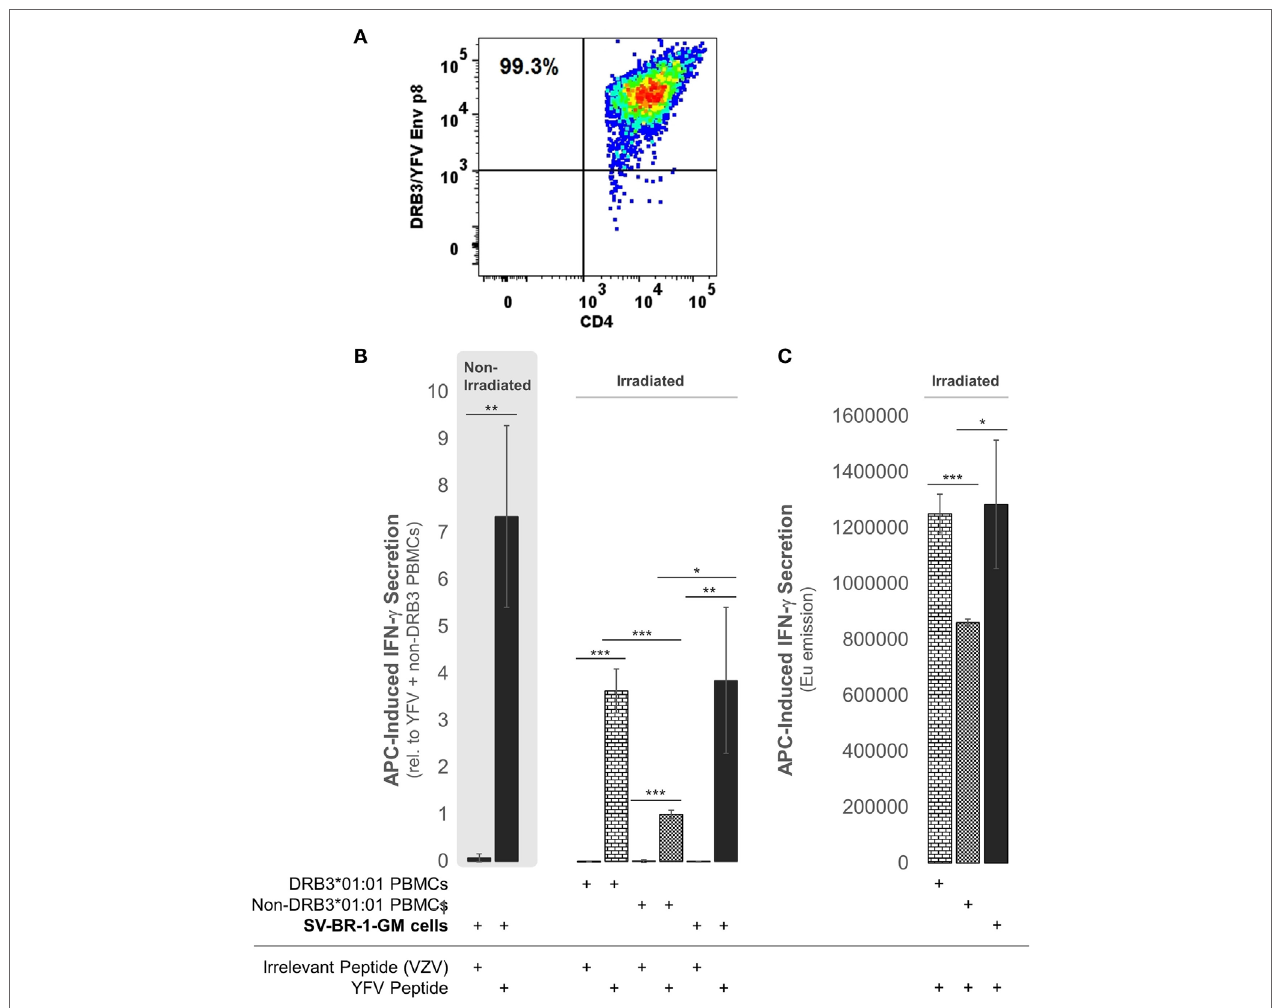
FigUre 9 | SV-BR-1-GM cells act as antigen-presenting cells (APCs). SV-BR-1-GM cells were cultured and serum-starved for 24 h then coincubated with yellow fever virus (YFV) Envelope (Env) 43–59 peptides (35) known to bind to HLA-DR complexes with an HLA-DRB3*01:01 -based β chain and a YFV-DRB3*01:01-specific CD4 + T cell clone (a) . (a) T cell clone after staining with YFV Env p8/DRB3*01:01 tetramers, as assessed by flow cytometry. Almost all T cells are both YFV Env p8/ DRB3 and CD4 positive. (B) After 72 h of coculturing, T cell activation was assessed by determining the levels of secreted interferon (IFN)- γ . Values shown are arithmetic means from technical triplicates ± SDs, normalized to the mean IFN- γ level obtained from the YFV peptide-treated non-DRB3 PBMC reference wells. Background